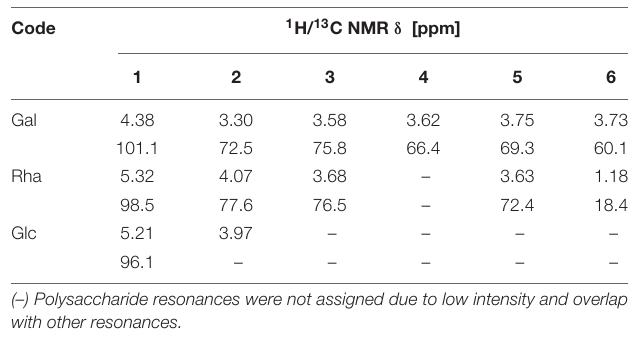
Frontiers in Nutrition |